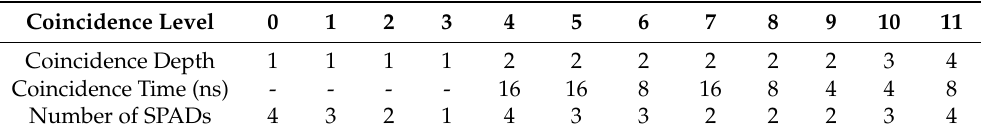
Table 1. Coincidence parameters of the chosen coincidence level for decreasing event rate.